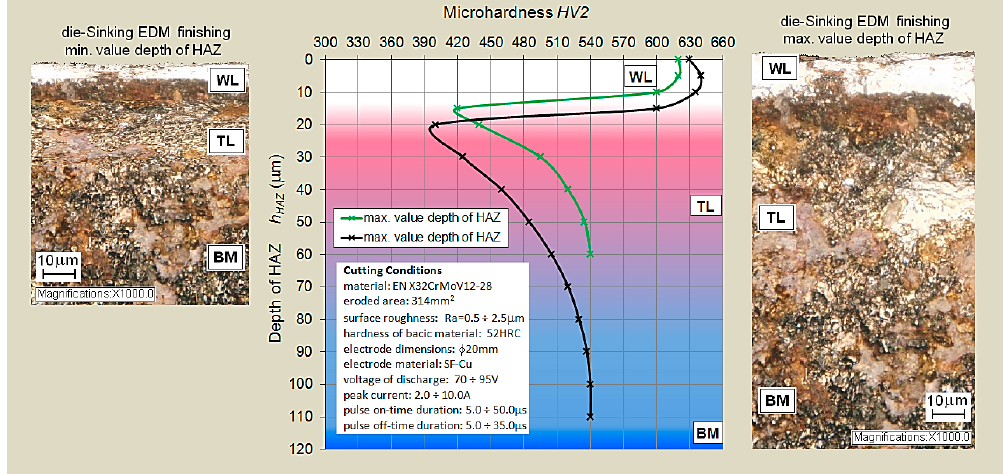
Figure 10. Microhardness HV 2 values recorded in particular HAZ layers (BL, WL, and TL) of tool steel EN X32CrMoV12 ‐ 28 after die ‐ sinking EDM roughing with SF ‐ Cu